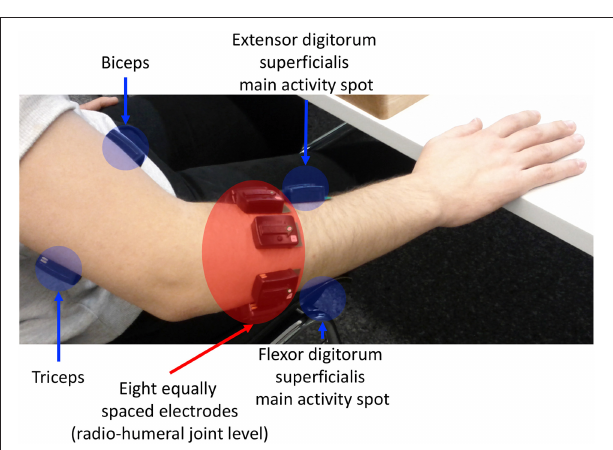
FIGURE 2 | sEMG electrode placement: an array of 8 equally spaced electrodes was worn at the forearm level (labeled f1-f8), two probes on finger flexors and extensors, and on biceps caput longus and triceps caput medialis, according to the protocol introduced in the Ninapro database (Atzori et al., 2014a).